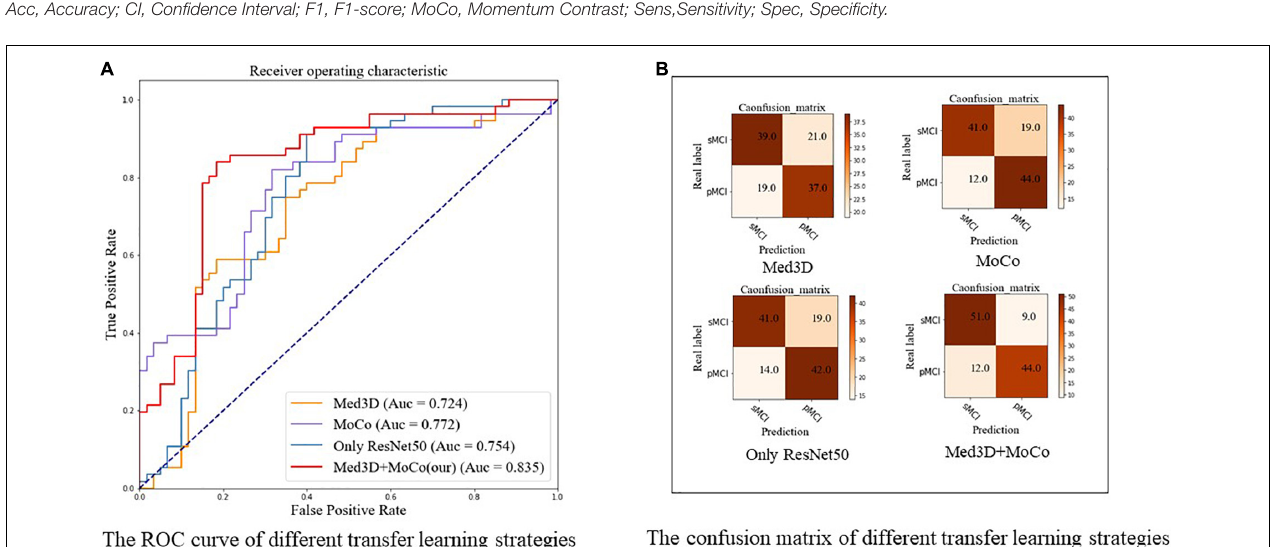
FIGURE 7 | The ROC curve and confusion matrix of different transfer learning strategies using ResNet-50. (A) The ROC curve. (B) The confusion matrix, respectively. All the models in this figure use ResNet-50. Med3D, pre-trained ResNet-50 using Med3D and fine-tune the model to complete the classification of sMCI and pMCI; MoCo, random initialization of weights, followed with the modified MoCo in the method to train the ResNet50 without using sMCI/pMCI labels. Then fine-tune the model using labeled data and complete the classification; Only ResNet, random initialization of weights and training ResNet from scratch; Med3D+MoCo, our two-stage transfer learning model; MoCo, Momentum Contrast; pMCI, progressive mild cognitive impairment; sMCI, stable mild cognitive